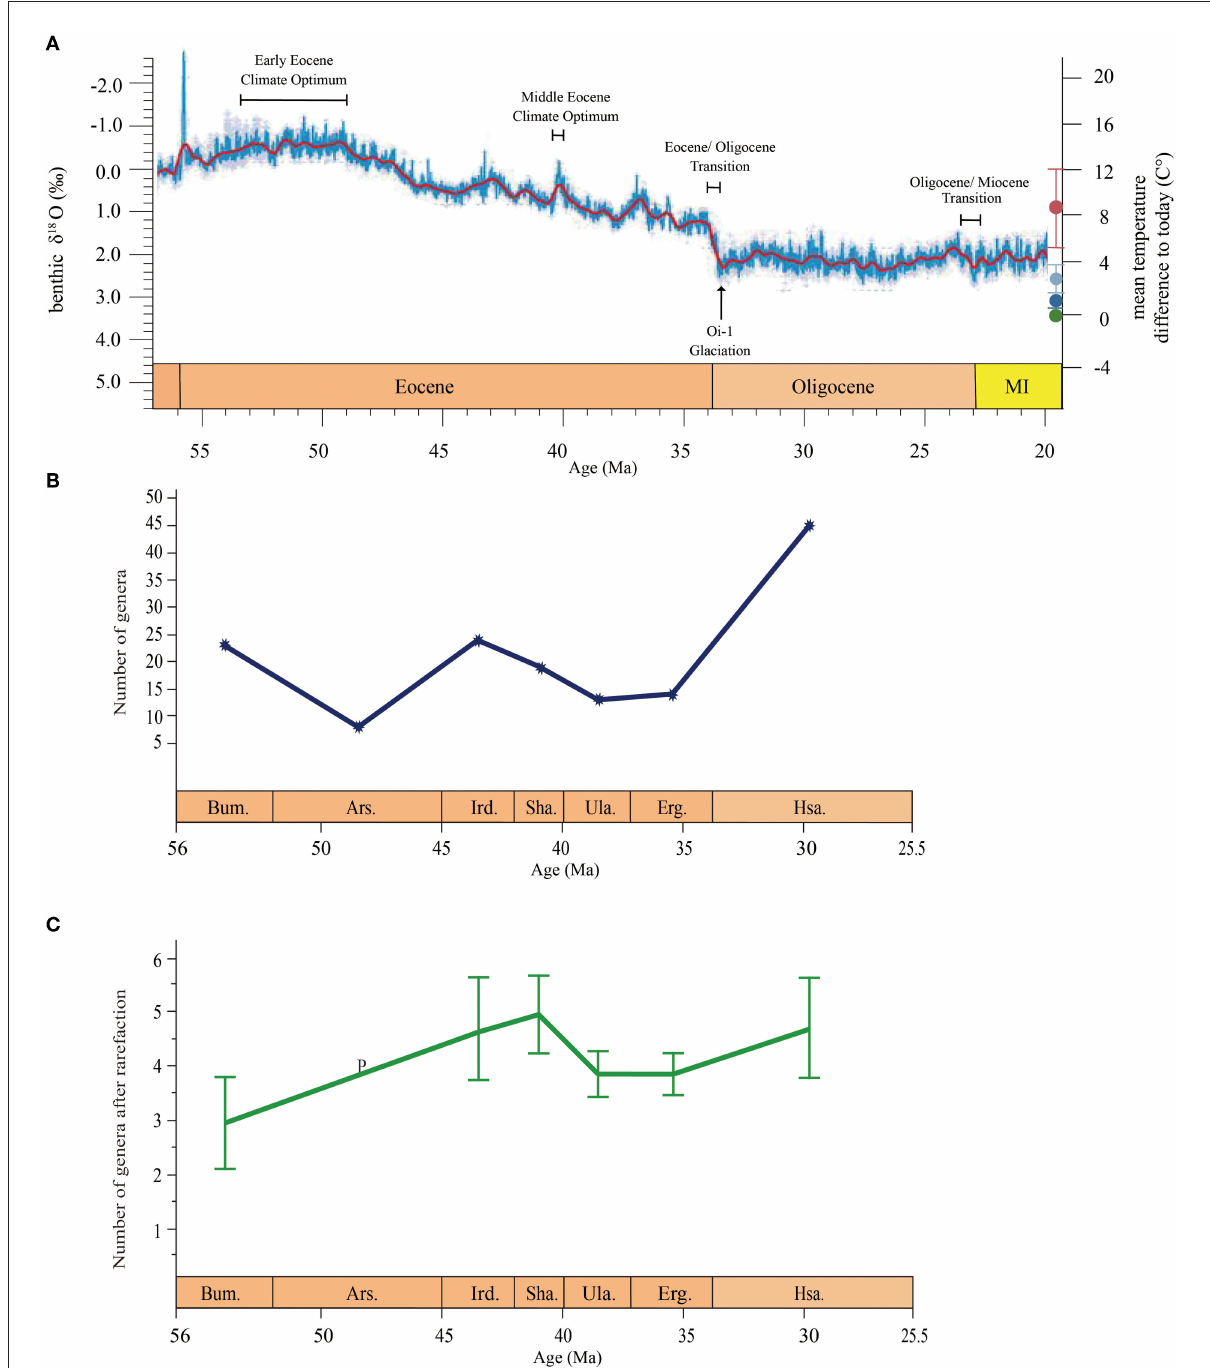
FIGURE9 (A,B) East Asian rodent genus-level diversity from the early Eocene to the early Oligocene in relation to global climatic change (modified from Westerhold et al., 2020). (C) Rodent diversity trajectory based on rarefaction estimates of genus richness for each series at a sample size of five genus occurrences. Error bars depict 95% confidence intervals around the estimates. Bum., Bumbanian; Ars., Arshantan; Ird., Irdinmanhan; Sha., Sharamurunian; Ula., Ulangochuian; Erg., Ergilian; Hsa.,